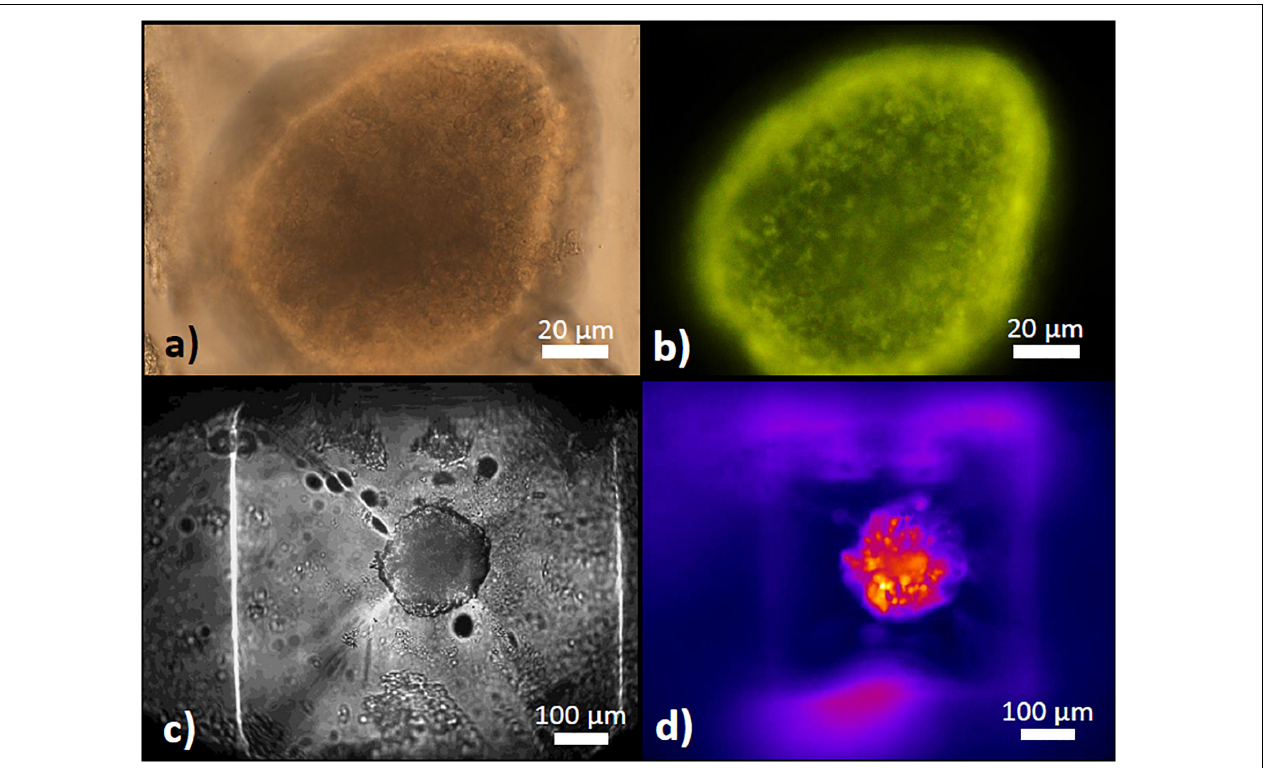
FIGURE 3 | The pyramidal well for islet retention. (a) Appearance of a mouse islet within the well as seen from above with a 40x dry objective in transmitted light. (b) Appearance of the same islet as in (a) under epifluorescent excitation of TMRE fluorescence, labeling the mitochondria within the islet cells. (c) Appearance of a mouse islet within the well as seen from below with a 10x dry objective in transmitted light on an inverted microscope stage. (d) Appearance of the same islet as in (c) under epifluorescent excitation of Fura-2 AM fluorescence to determine [Ca 2 + ] i